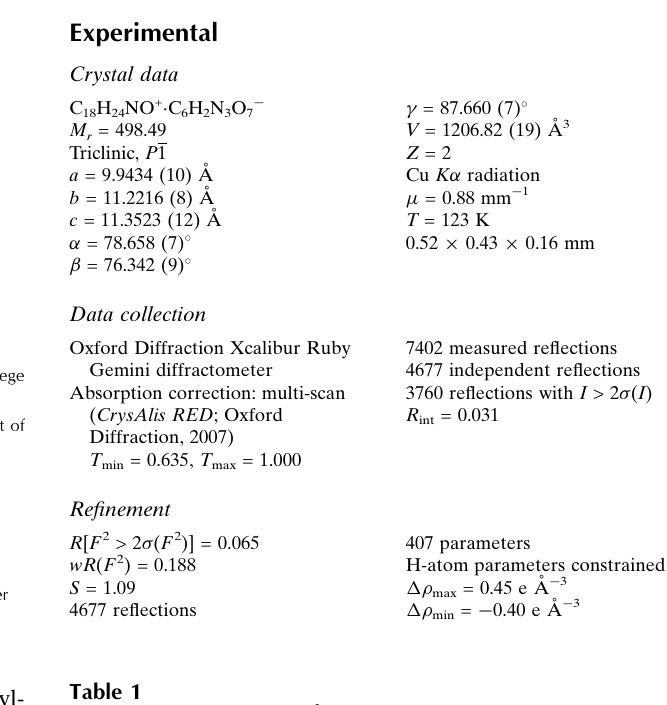
Hydrogen-bond geometry (A˚ , (cid:4) ). Cg 2 and Cg 3 are the centroids of the C9 A –C7 A and C2 C –C7 C rings,